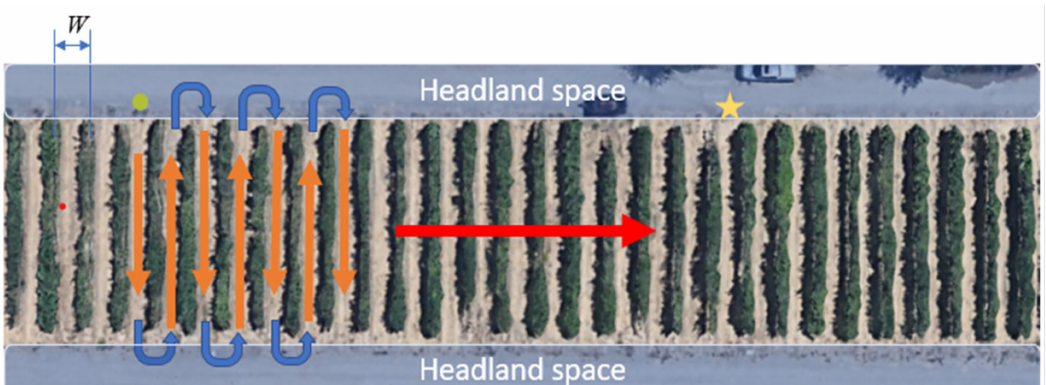
Figure 1. Top view (from a satellite image) of a typical vineyard block: vines, rows between the vines, and headland space. The symbols represent a typical field coverage navigation task. The robot starts at an initial position near the entrance of a user-defined row (green dot); it traverses a set of rows (orange vertical arrows) toward a specific direction (red arrow points from left to right); and exits from a user-defined row (yellow